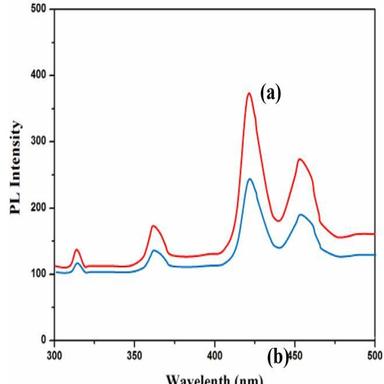
PL analysis (a)SnO2 nanocomposite material and (b)CdO-SnO2 nanocomposite material.